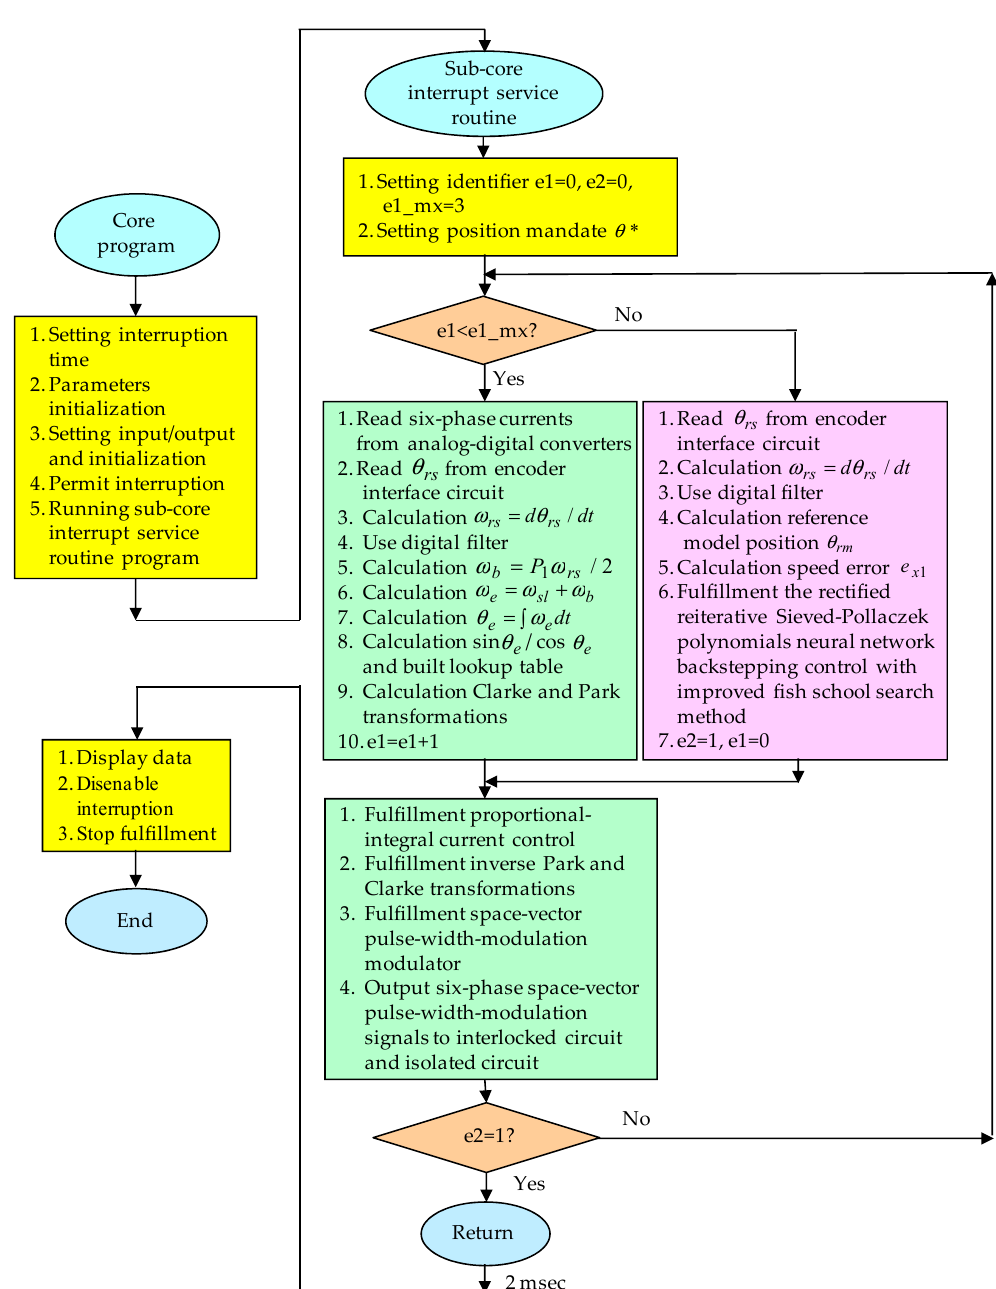
Figure 7. Flow chart of the realized program by utilizing a digital signal processor control system.